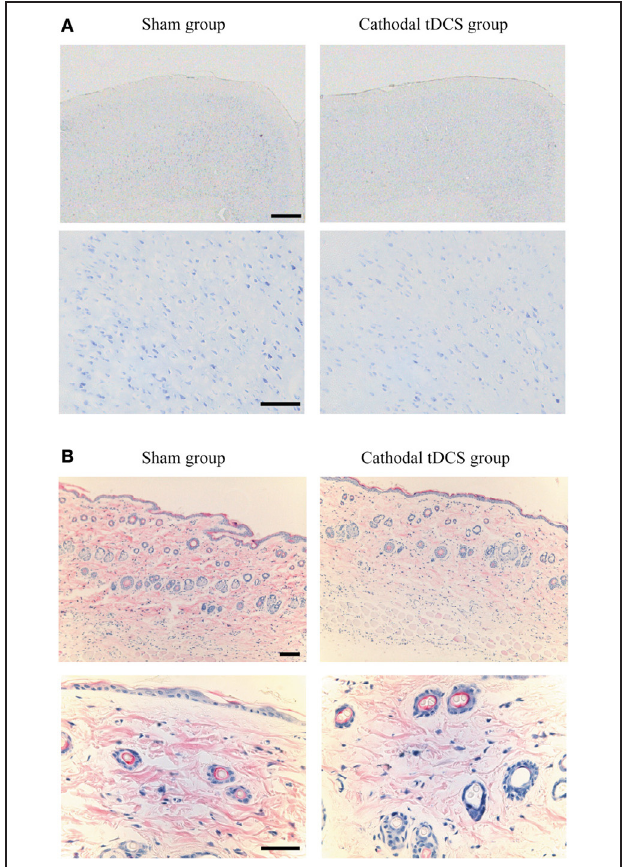
FIGURE 4 | Histological examination following tDCS. (A) Cresyl violet staining of the brain tissue below the scalp electrode in the sham group (left) and the cathodal tDCS group (right) 24h after tDCS application. Scale bars: 1mm for upper panels, 100 μ m for lower panels; (B) HE staining of the skin below the scalp electrode in the sham group (left) and the cathodal tDCS group (right) 24h after tDCS application. Scale bars: 100 μ m for upper panels, 50 μ m for lower panels. No morphological change was observed in brain tissue and